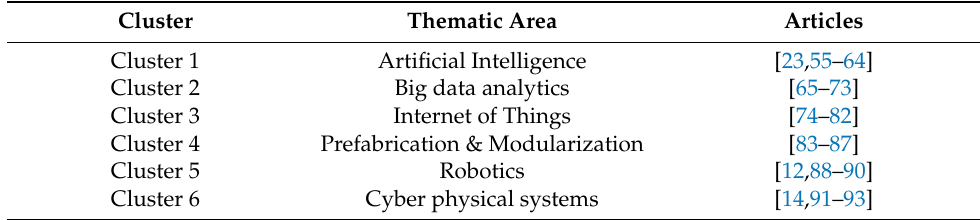
Figure 10. Word clouds of the final clusters based on 70 retrieved articles. Table 1. Literature classification from co-citation analysis.